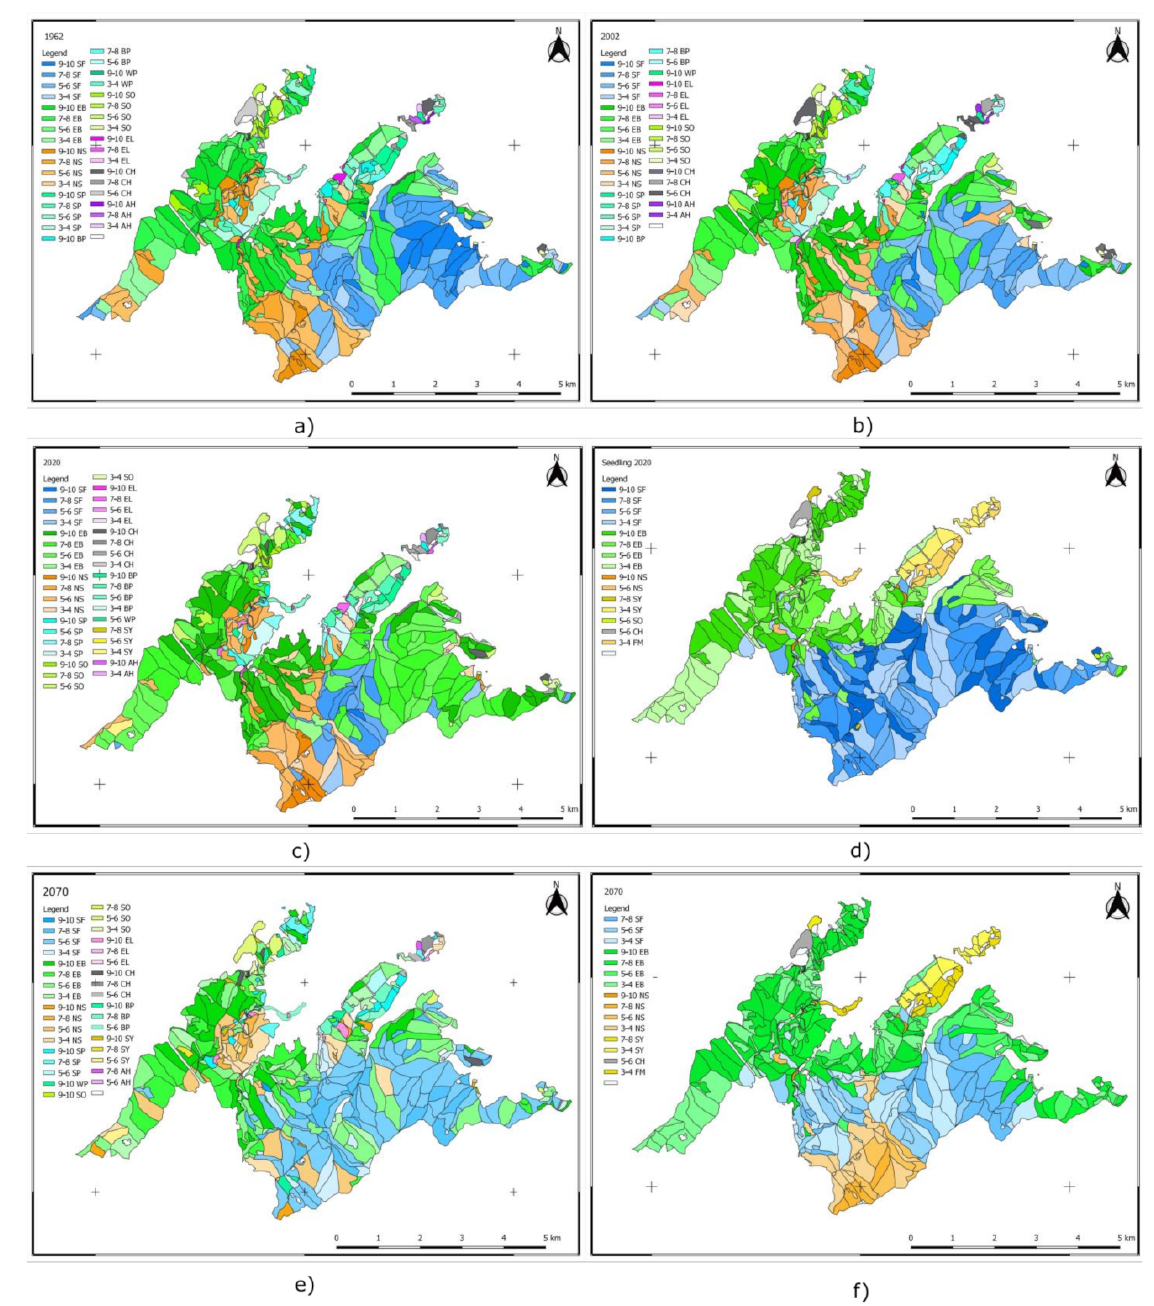
Figure 9. Species distribution maps (based on the predominant species in each stand) between 1962 and 2020, and at the level of 2070. Forest composition in 1962 ( a ), 2002 ( b ), and 2020 ( c ); seedling composition in 2020 ( d ); target composition in 2070 (1) ( e ); and target composition in 2070 (2) ( f ). SF—silver fir, EB—European beech, NS—Norway spruce, SP—Scots pine, BP—Austrian black pine, WP—white pine, SO—sessile oak, EL—European larch, CH—common hornbeam, AH—European ash, SY—sycamore, and FM—field maple. The figure illustrates: the pronounced change in forest composition between 2002 ( b ) and 2020 ( c ); the promotion of seedlings in the composition forecast for 2070 (target composition (1)) based on the chosen climate scenario ( e ); target composition (2)—promotion of a composition of natural forest types, a reduction in the proportion of spruce in mixtures located at altitudes below 1000 m (maintaining spruce stands through natural regeneration and replacing those planted outside their area), and correlation of the target composition with the harvest regeneration plan for the next 50 years ( f